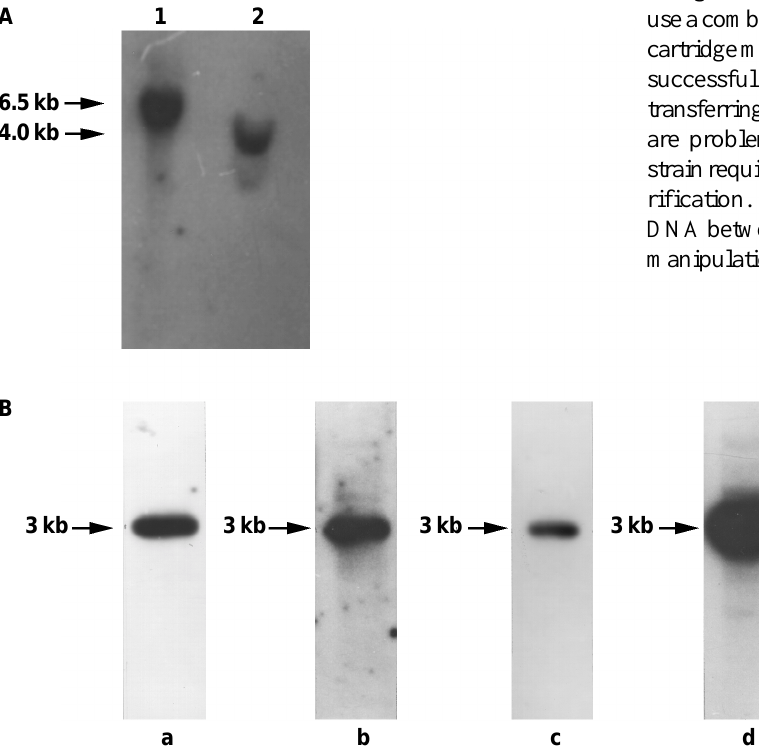
Figure 2 - Physical analysis of Km r -transformants of Azospirillum brasilense. Southern hybridization between Sp7Nif - 10 and 32 P-labelled DNA probes. λ DNA digested with Hin dIII was used as molecular weight standard. A) Total Sp7 DNA (lane 1) and Sp7Nif - 10 DNA (lane 2) digested with Eco RI and hybridized with nif HKm r K probe. B) Total Sp7Nif - 10 DNA digested with Pst I and hybridized with nifHDK (a), nifH (b), nifD (c), and nifK (d)